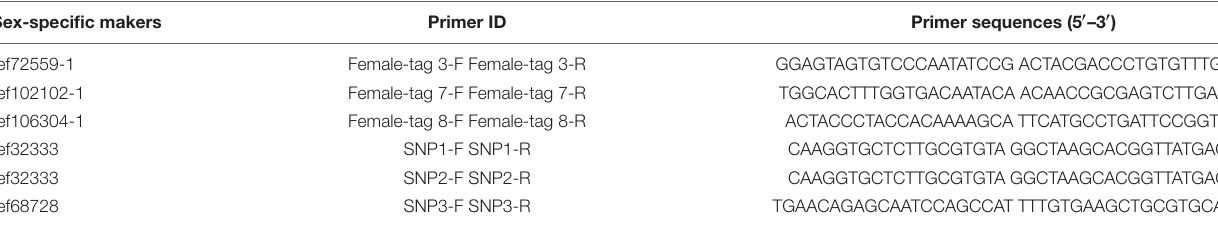
TABLE 5 | primers used to verify candidate sex-specific tags and SNPs.